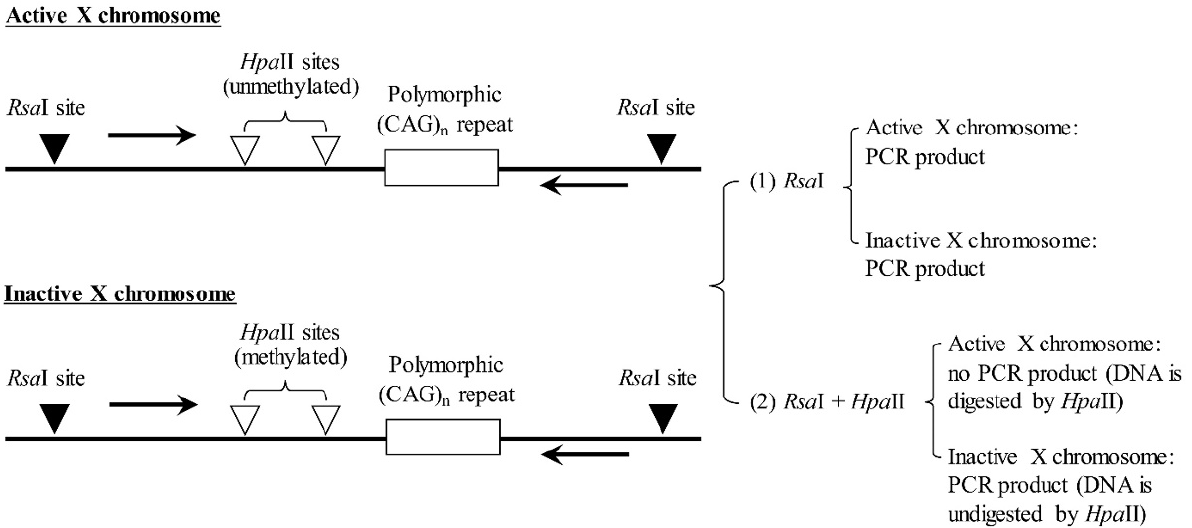
Figure 2. Schematic diagram of the X-chromosome inactivation (XCI) analysis of androgen receptor (AR) to distinguish between active (unmethylated) and inactive X (methylated) chromosome in females by restriction enzymes of RsaI (methylation insensitive) and HpaII (methylation sensitive), followed by polymerase chain reaction (PCR) amplification of a polymorphic (CAG)n repeat in AR. In the test of the “ RsaI ” aliquot, DNA fragments are amplified from both X chromosomes, regardless of their activity status. In the test of the “ RsaI + HpaII ” aliquot, only the DNA fragment on the inactive X chromosome is amplified. The degree of XCI was determined based on the ratio of the peak height of each AR allele in relative to the sum of the heights of both AR alleles.